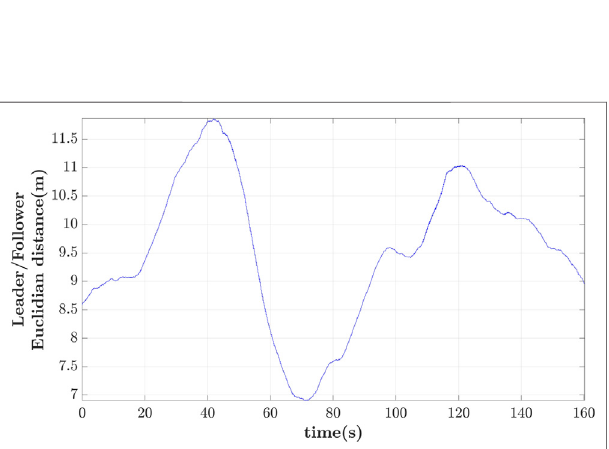
FIGURE 9 | GPS-altitude relative error for stationary